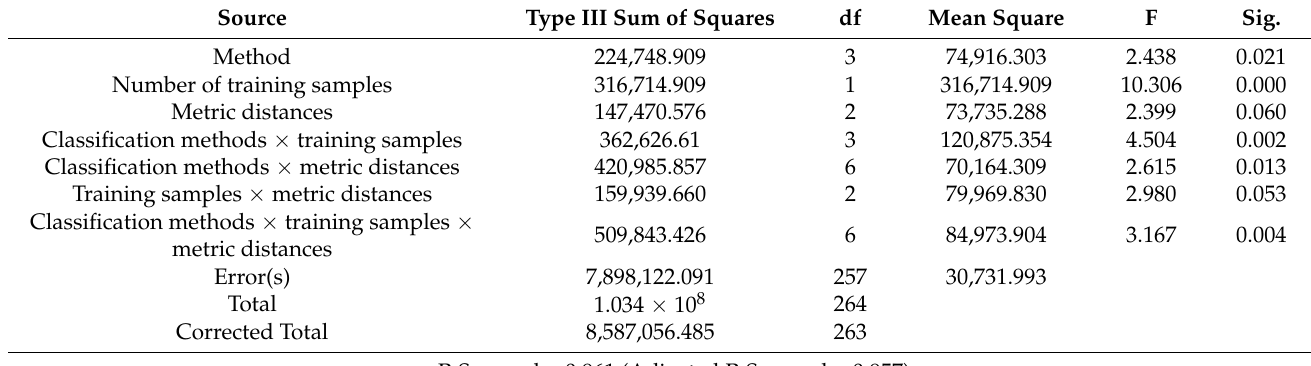
Table 2. ANOVA for the effect of classifier, training sample size, and metric distance on stem identification score.